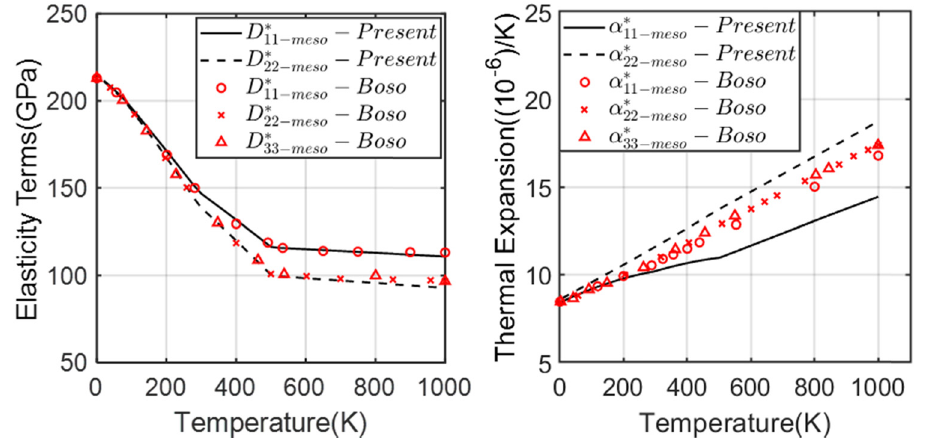
Figure 9: Comparison of homogenized main diagonal elasticity terms ( Left ) and thermal expansion coe ffi cients ( Right ) generated by LEHT and Boso et al. [ 13 ] with v 0.72 f = at mesoscale.